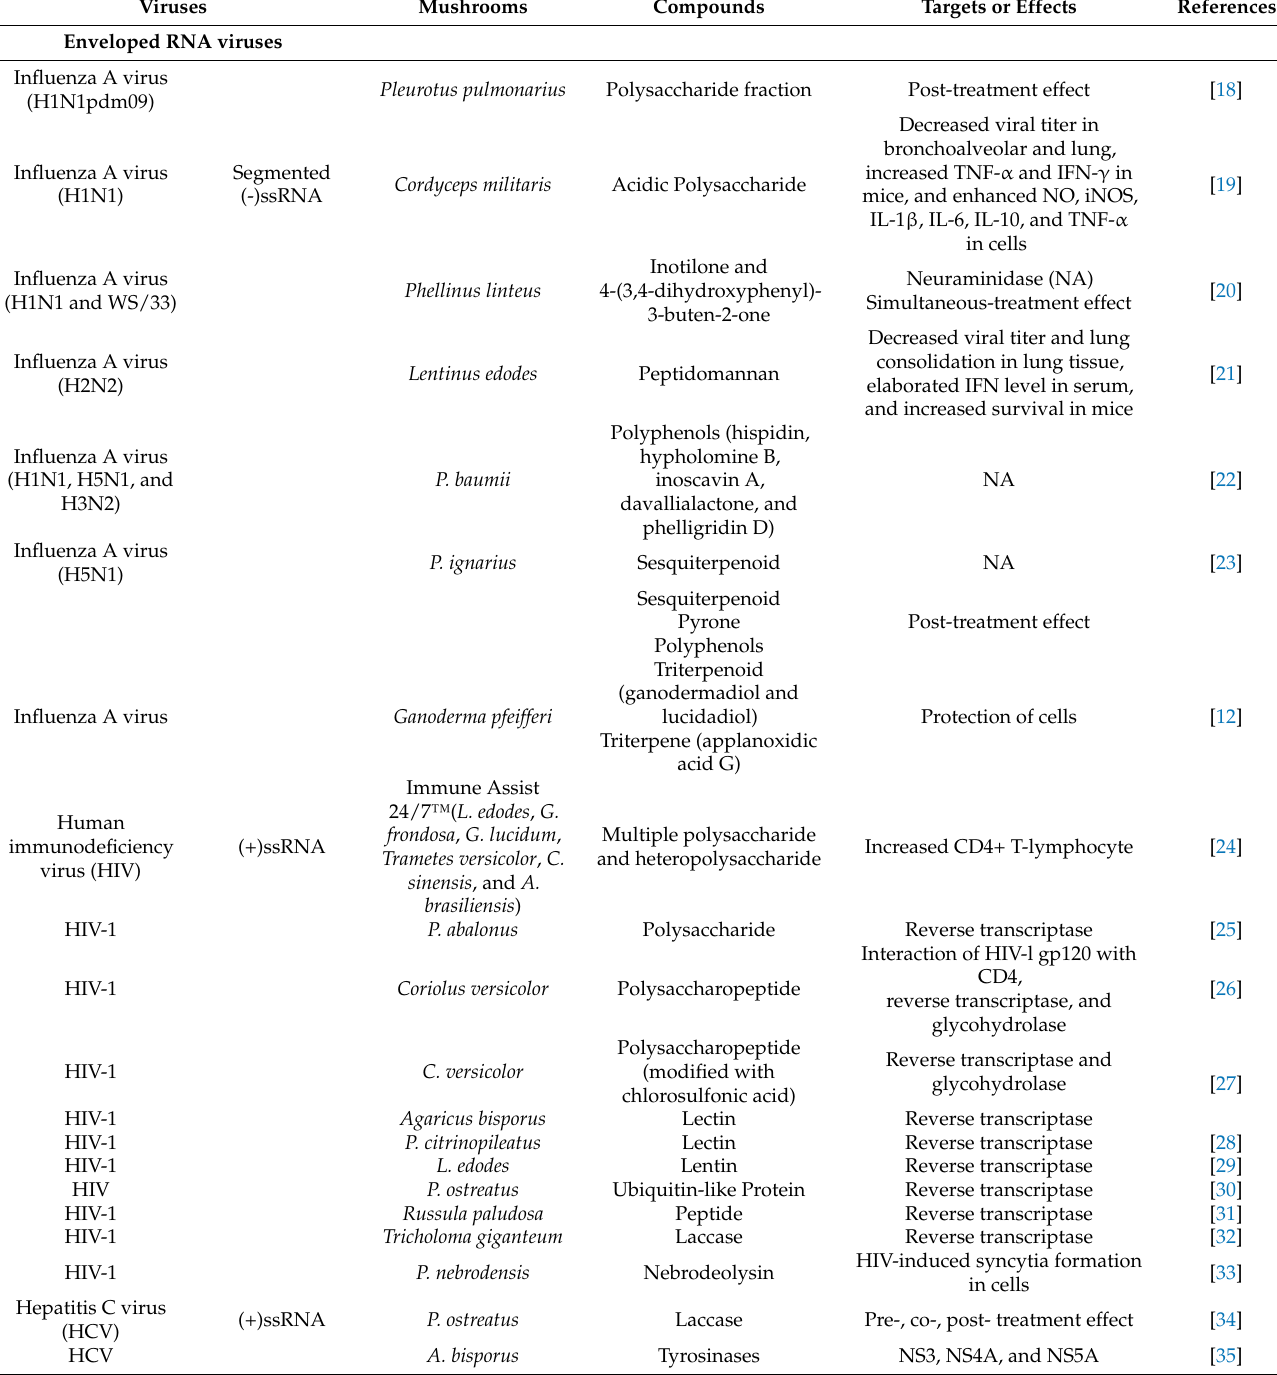
Table 2. Mushroom compounds and their antiviral targets against enveloped RNA